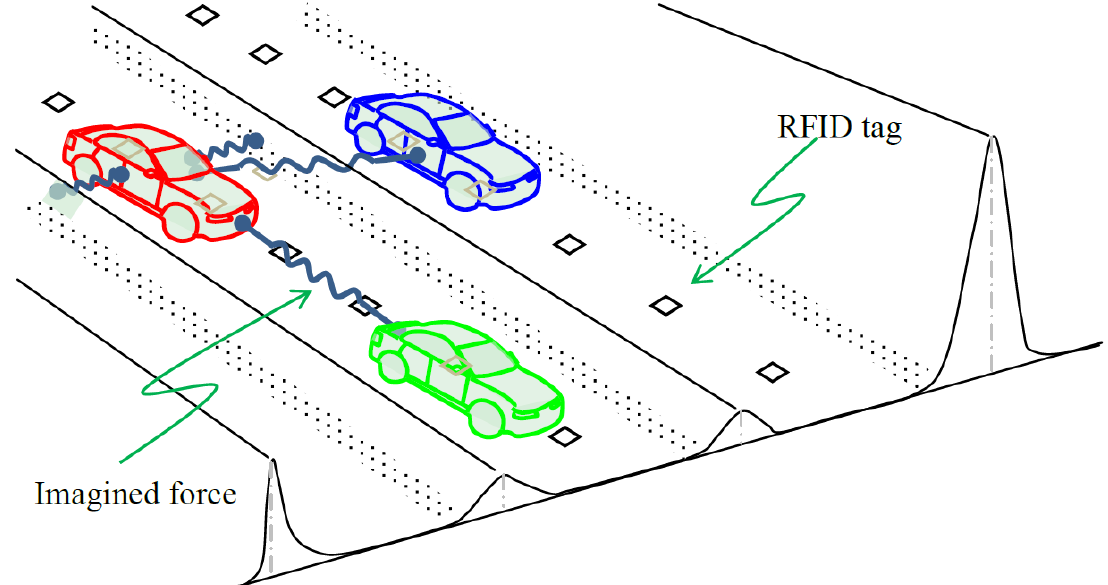
Figure 9. Application of RFID positioning in operational control of connected